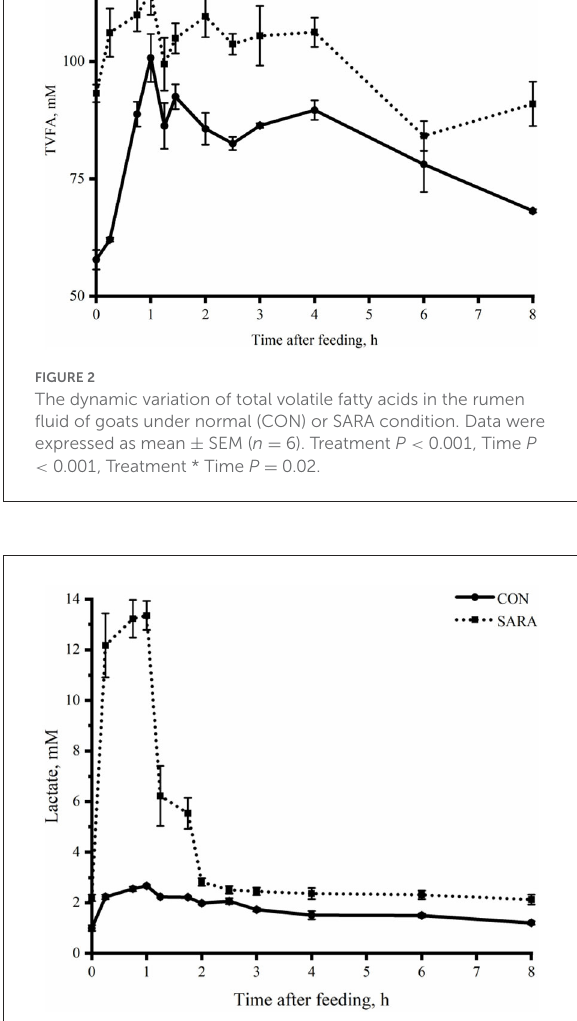
concentrations were shown in goats from 2 to 4 h after morning feeding ( p < 0.05). In addition, the goats in SARA showed greater lactate concentrations throughout the whole feeding time ( p < 0.05). The goats in SARA had high concentrations of propionate, butyrate, isobutyrate, valerate, isovalerate, lactate, and free LPS in the ruminal fluid compared with the CON goats ( p < 0.05). However, there was no significant difference in the ruminal acetate concentrations among treatments ( p >